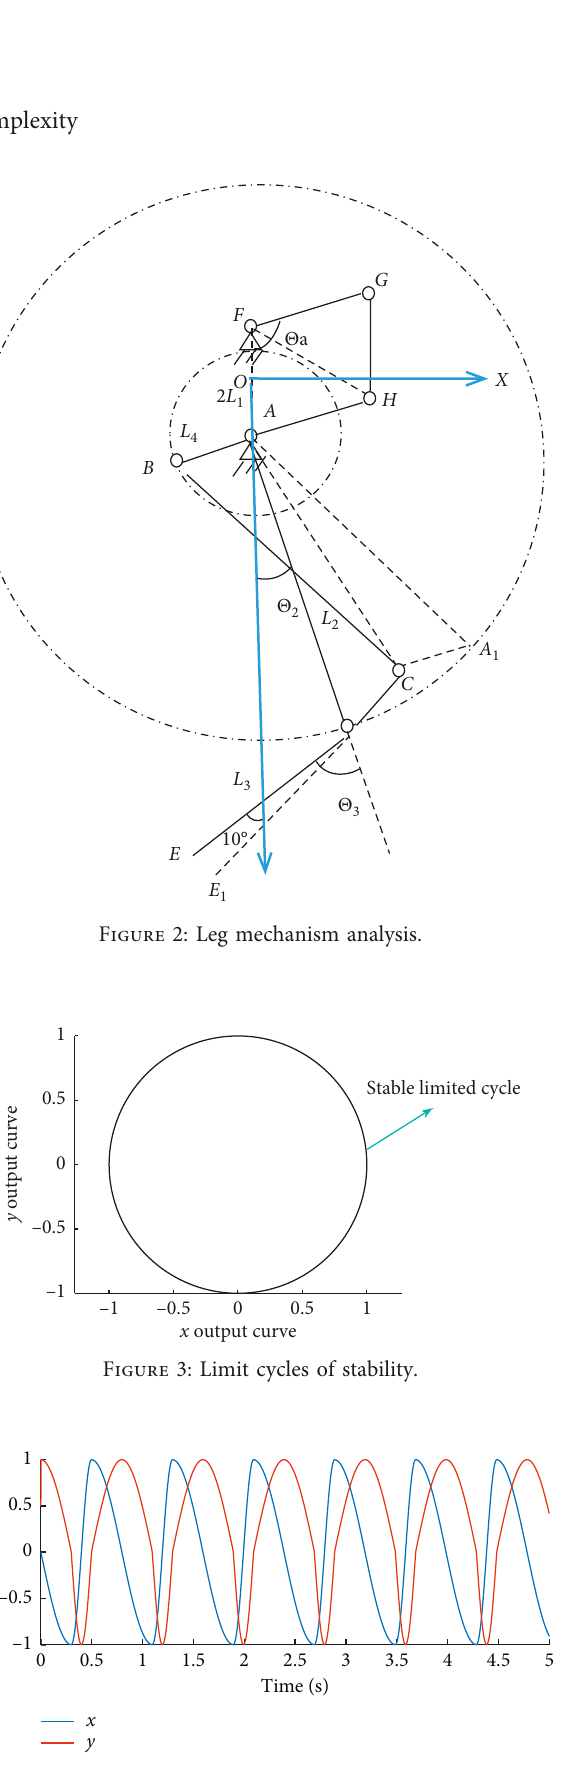
Figure 4: Hopf oscillator